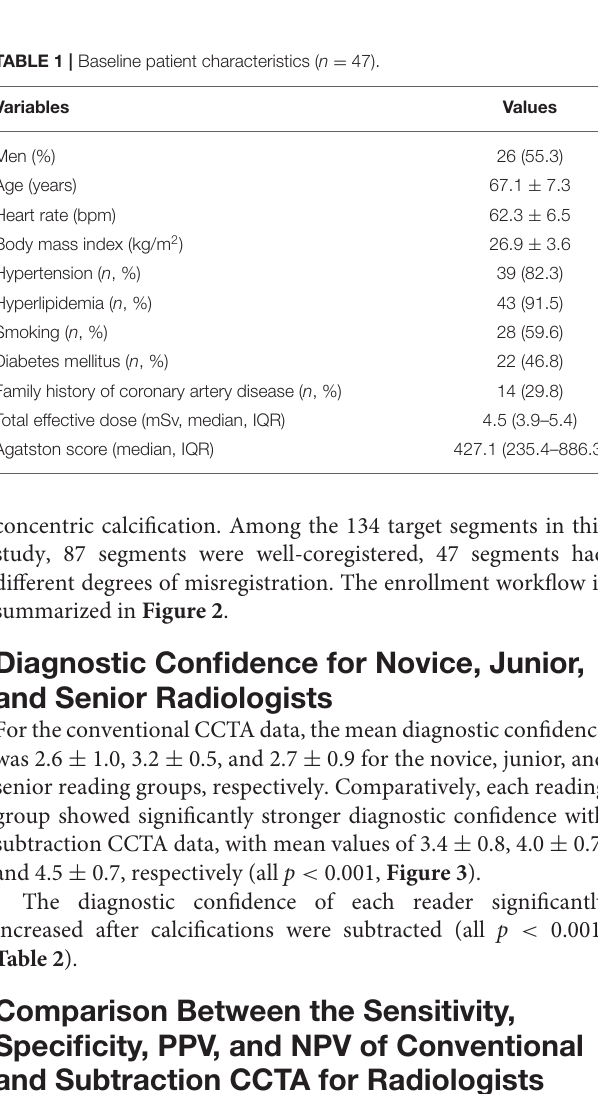
FIGURE 1 | Patient showing stenosis regrading in conventional CCTA and subtraction. VR (A) , Axial (B) , and CPR (D) images of proximal left anterior descending artery with severe calcification on conventional CCTA. Axial (C) and CPR (E) images for subtraction CCTA. The ICA image (F) . The arrow indicates calcified plaque with or without subtraction CCTA, and the same lesion on ICA. CCTA, coronary computed tomography angiography; VR, Volume rendered; CPR, curved planar reconstruction; ICA, invasive coronary angiography.